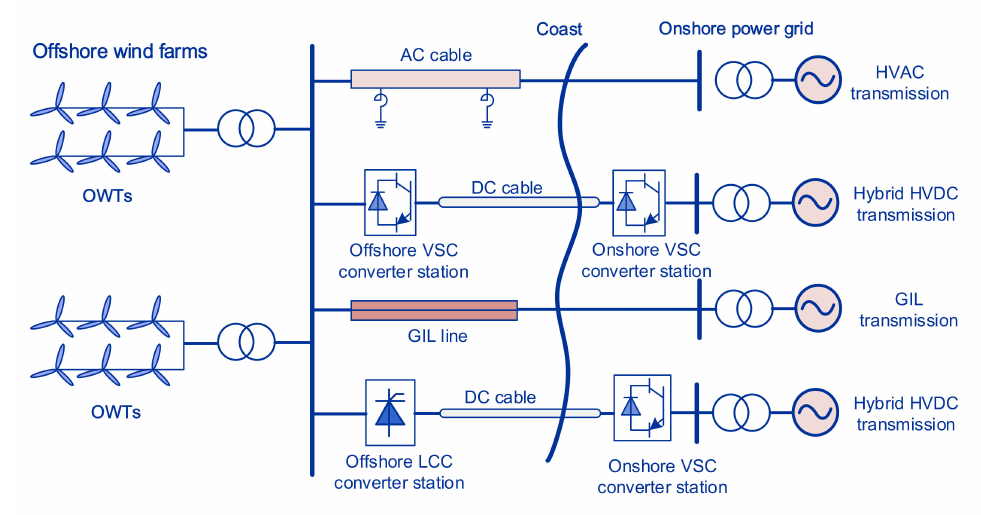
Figure 2. Structure of the four transmission methods for